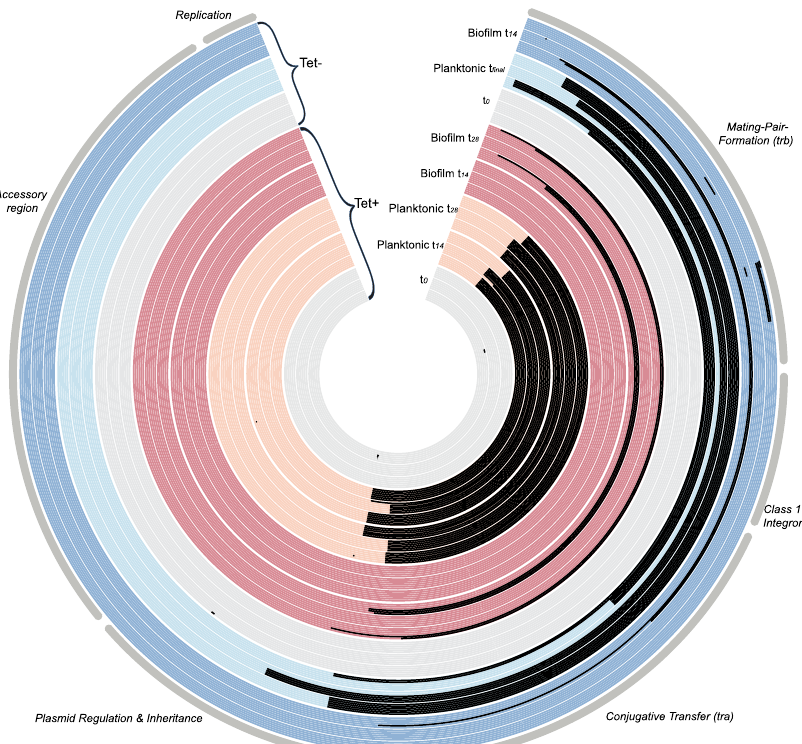
Fig. 3 Maps of evolved plasmids with major segment functions identi fi ed, showing all plasmid mutations observed in each sequenced clone evolved under different treatments (Tet + and Tet − ) in different environments (bio fi lm and planktonic populations). Evolved clones are grouped by treatment, environment, and time point, as shown by different colors and shades, and identi fi ed in the open wedge of the circle. The plasmid genome of each clone is shown as a single band — at each time point, 18 clones were analyzed per treatment and environment (six clones from each triplicate population). Tet + , Tet − : evolved with and without Tet. Black areas in the plasmid maps represent deletions (note that small indels are shown as small spots), and the dots represent SNPs; see Supplementary Table 1 for details. Note that the tetracycline resistance operon is located in the ‘ accessory region ’